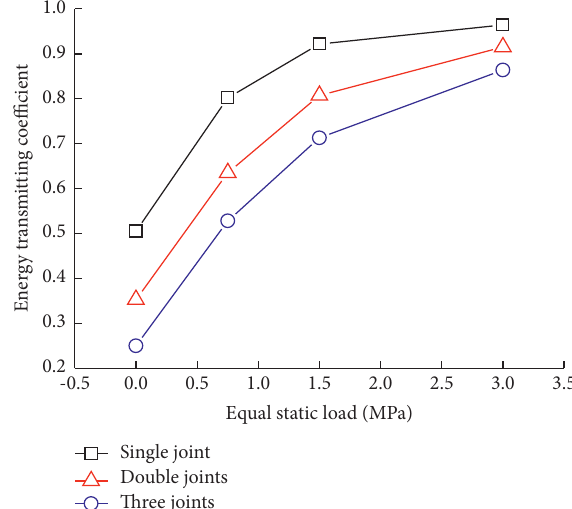
Figure 14: Energy transmitting coefficients of stress wave at joints under different equal static